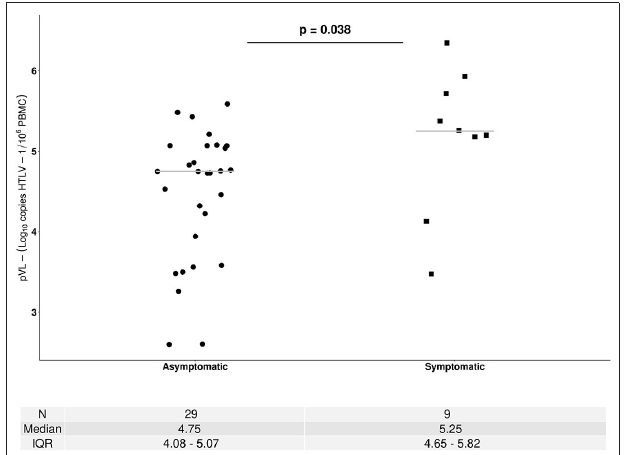
FIGURE 3 | Human T-cell lymphotropic virus 1 proviral load (pVL) among asymptomatic carriers (ACs) and symptomatic patients (SPs). HTLV-1 pVL values correspond to samples collected at first visit. • AC, N ATL, (cid:4) HAM/TSP. The Mann–Whitney U -test was used to compare continuous data between ACs and SPs. A two-sided p < 0.05 was considered to indicate statistical